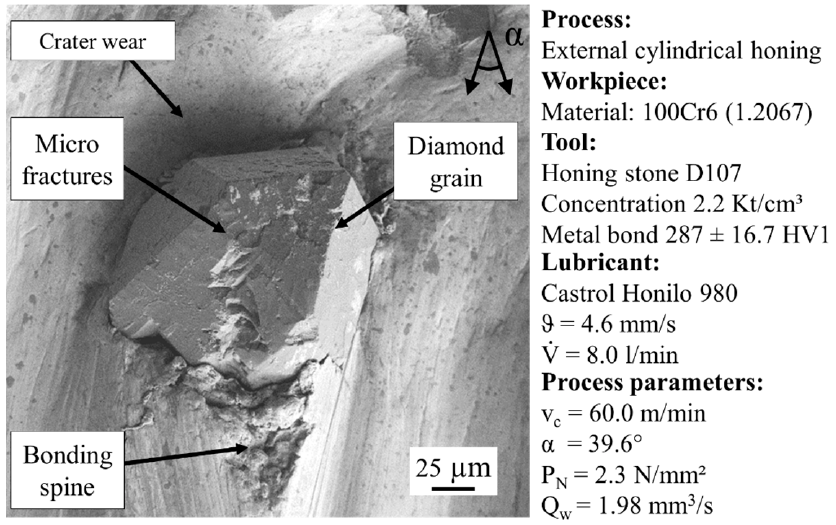
Figure 6. Wear marks for monocrystalline grains on prehoning.